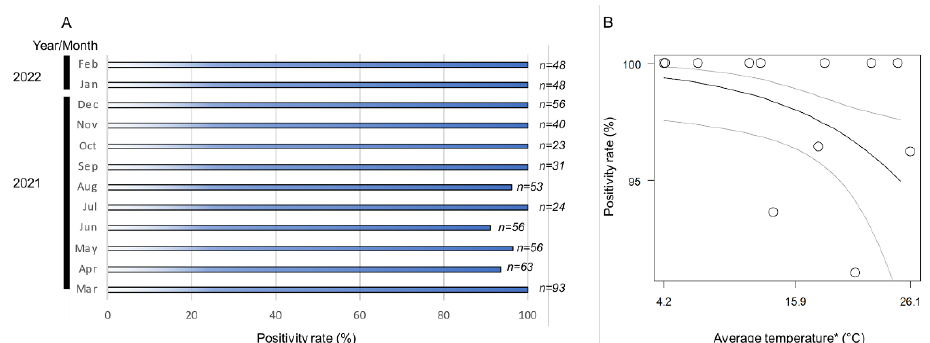
Figure 3. ( A ) Nested PCR detection of the wsp gene revealed a positivity rate range of 91–100%; ( B ) logistic regression analysis on fixed infection across the seasonal temperature. Black line indicates regression line, while grey lines are upper and lower thresholds of 95% confidence interval of predicted line. Regression coefficient was significant (Wald test; p < 0.05). (*) Monthly average temperature data were retrieved from the Japan Meteorological Agency (https://www.data.jma.go.jp/; ac-